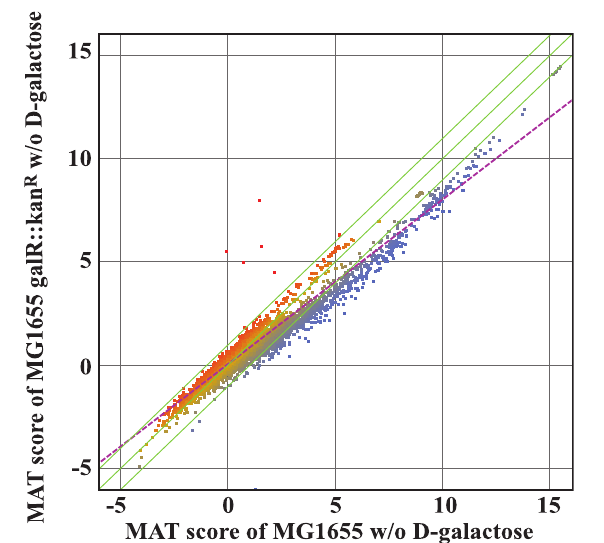
FIGURE 6 | MAT analysis of the transcriptome of wild type and ∆ galR cells grown in M63 minimal medium. Green lines represent the mean ± 2SD, while the purple dotted line represents the regression line. The red represents the up genes and the blue represents the down genes. There is a marked down-regulation of many genes in the absence of